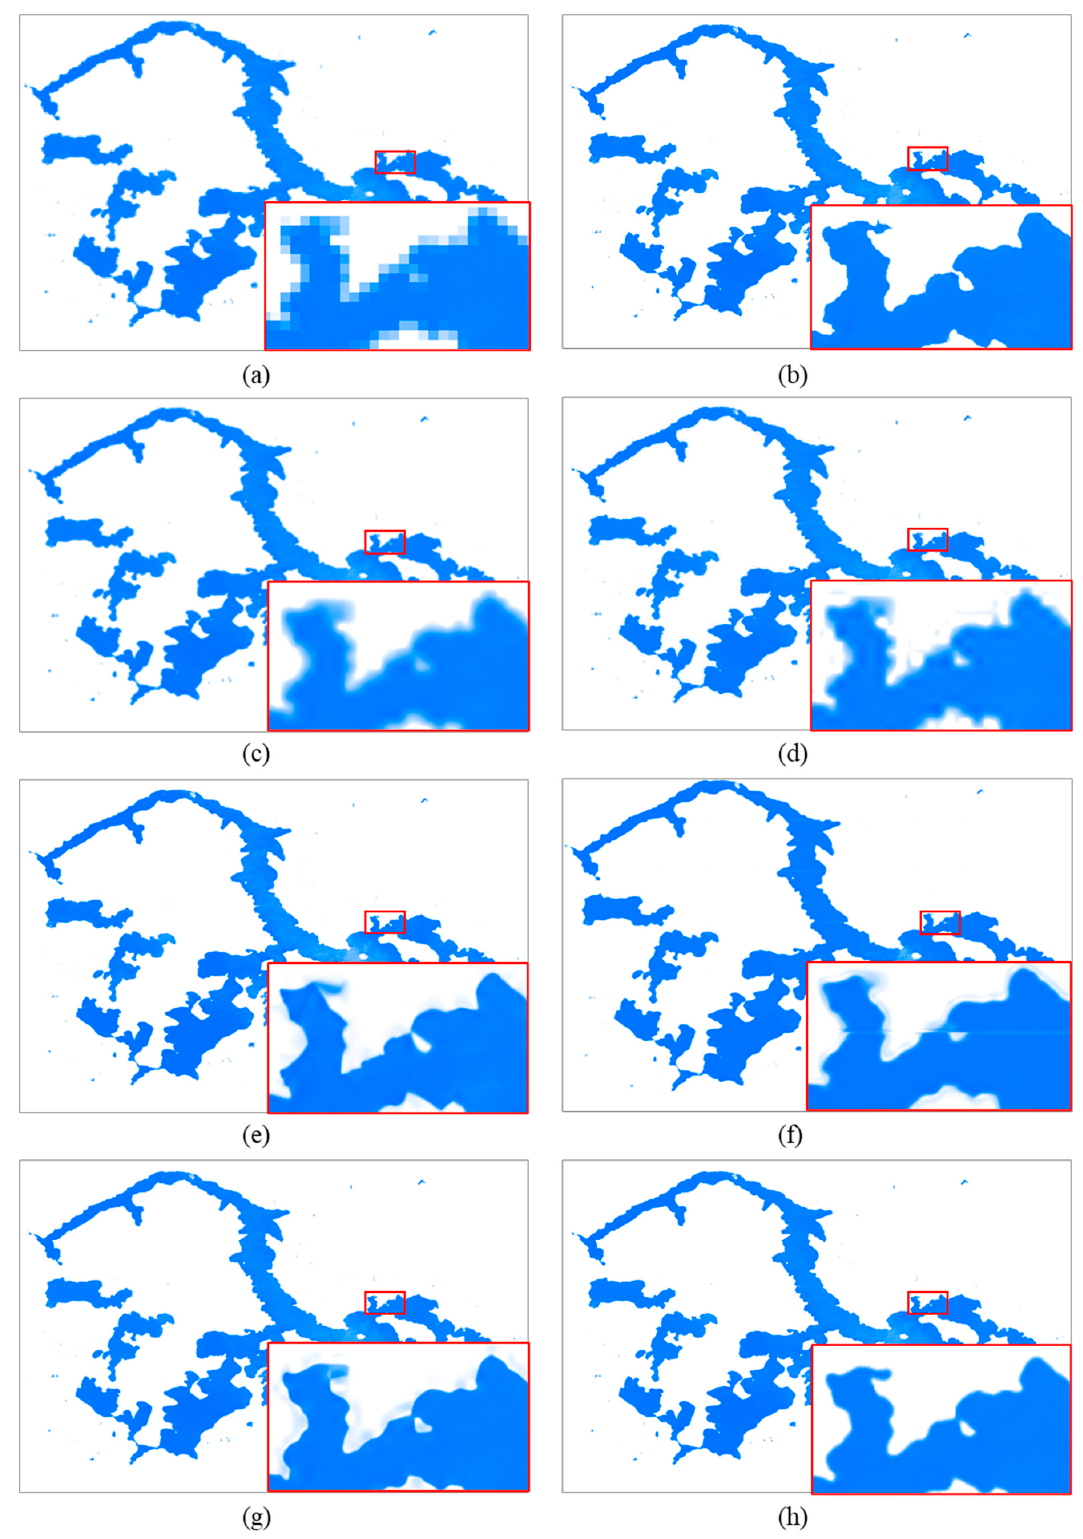
Figure 8. Normalized di ff erence water index (NDWI) image SR results obtained by di ff erent methods with an upscale factor of 8. ( a ) LR NDWI image, ( b )ground-truth NDWI image, ( c ) bicubic interpolation (BCI), ( d ) iterative back projection (IBP), ( e ) transformed self-exemplars (TSR), ( f ) SRCNN, ( g ) “zero-shot” super-resolution (ZSSR), ( h ) unsupervised deep gradient network (UDGN).